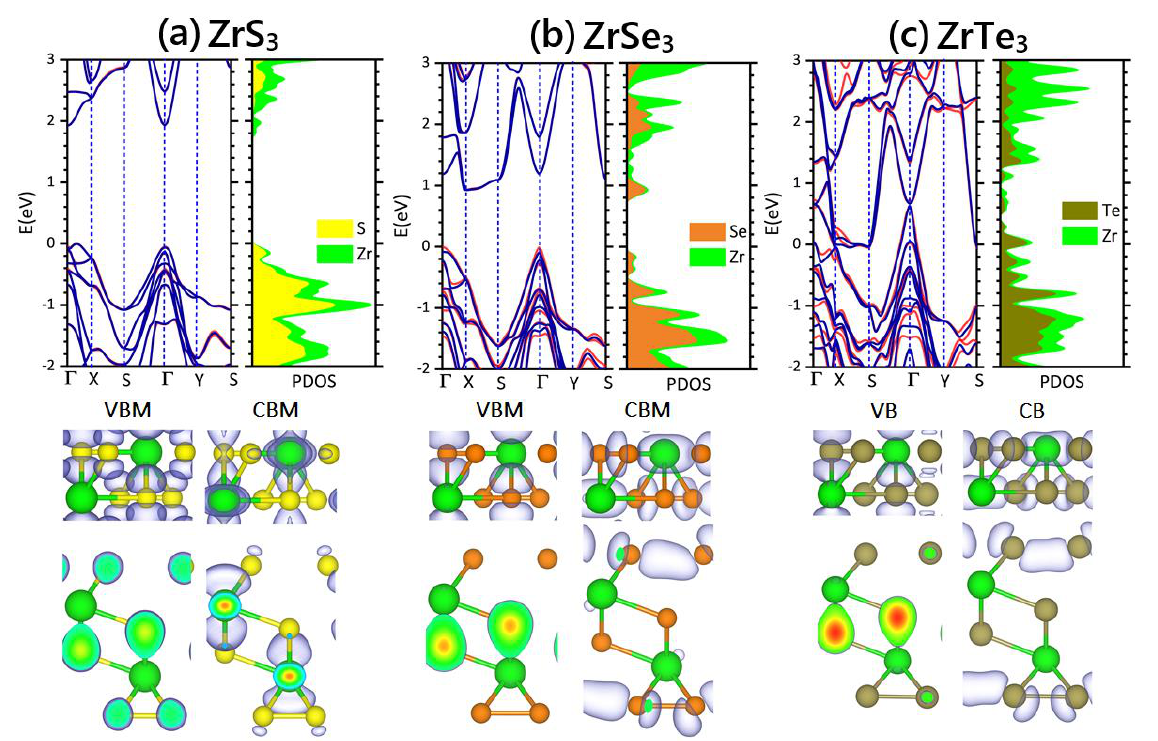
Figure 5. HSE06 band structures of ZrX 3 monolayers without (purple solid lines) and with (red solid line) the inclusion of SOC effects. Next to the band structures are the HSE06 calculated atom-type projected density of states. For ZrS 3 and ZrSe 3 , charge density distributions of their VBMs and CBMs are also shown. For ZrTe 3 that exhibits a metallic character, charge density distributions at two k-points below and above (−0.02 < E K -E Fermi < 0.02 eV) its Fermi level are shown. For both ZrS 3 and ZrSe 3 , VBM of HSE06 + SOC calculation is set to 0 and HSE06 band energies are aligned using vacuum-level calculations.